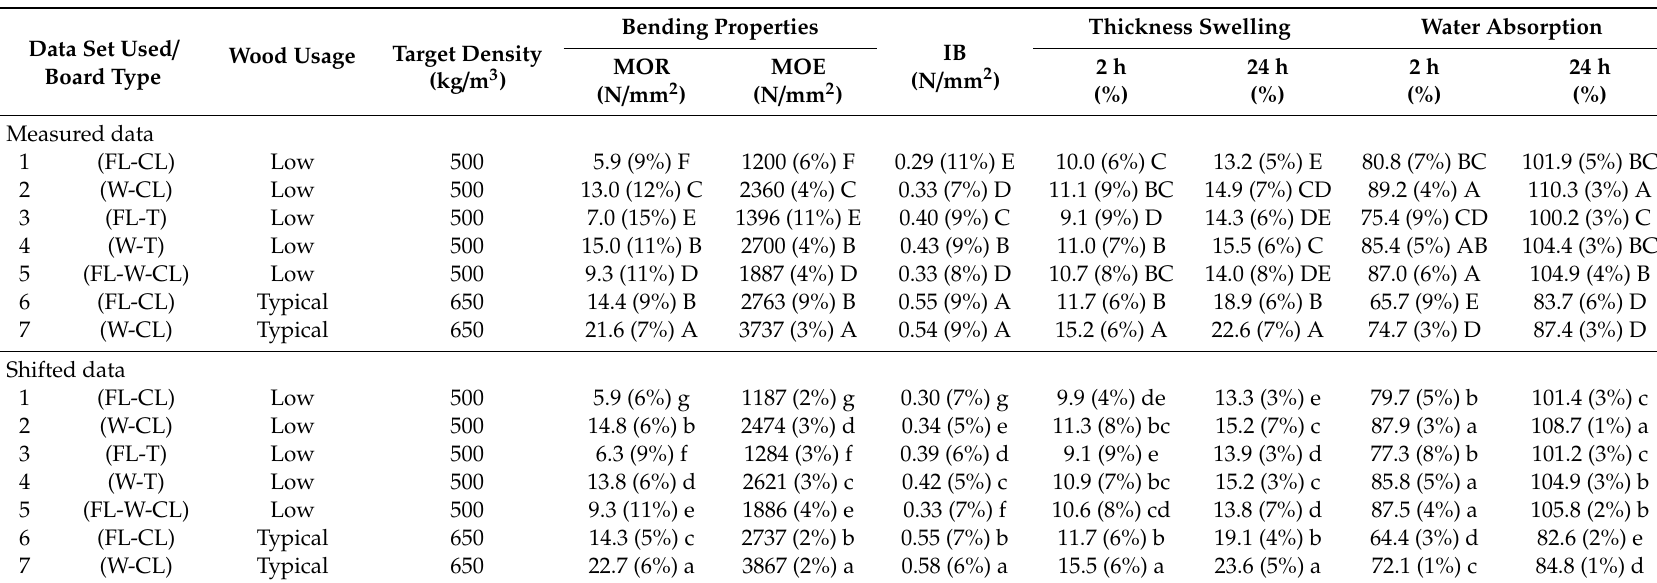
Table 8. Statistical characteristic values (mean value (coe ffi cient of variance)) of the measured and shifted board properties, and results (homogeneous groups, indicated by letters) of the statistical mean value comparison each, measured data (upper case letters), and shifted data (lower case